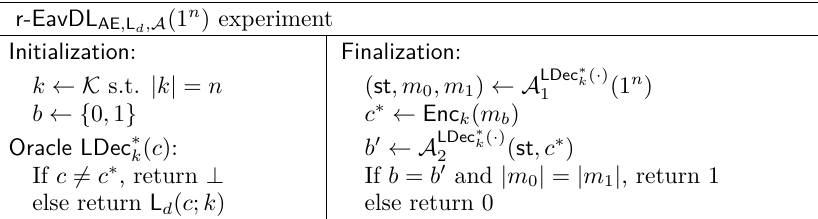
Table 6: Restricted EavDL